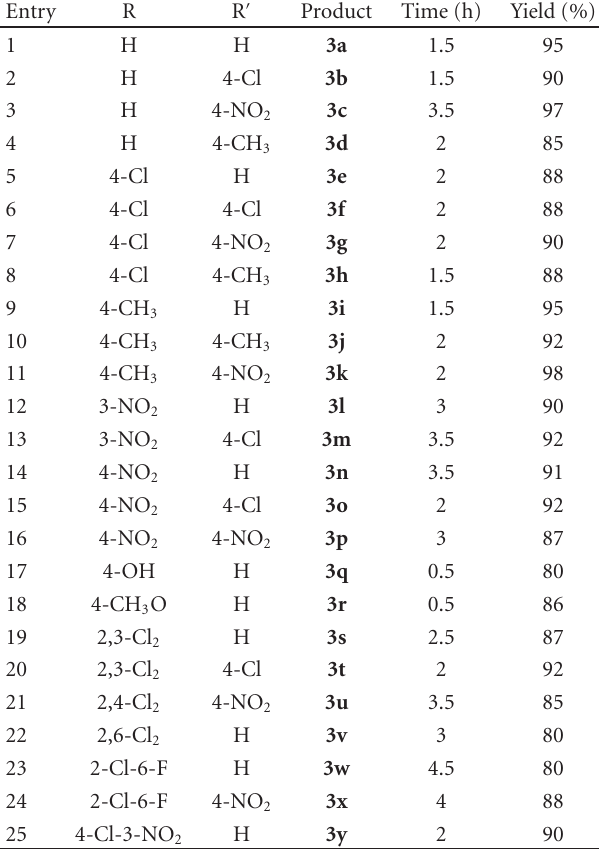
Table 1: Synthesis of β -acetamido ketones using boric